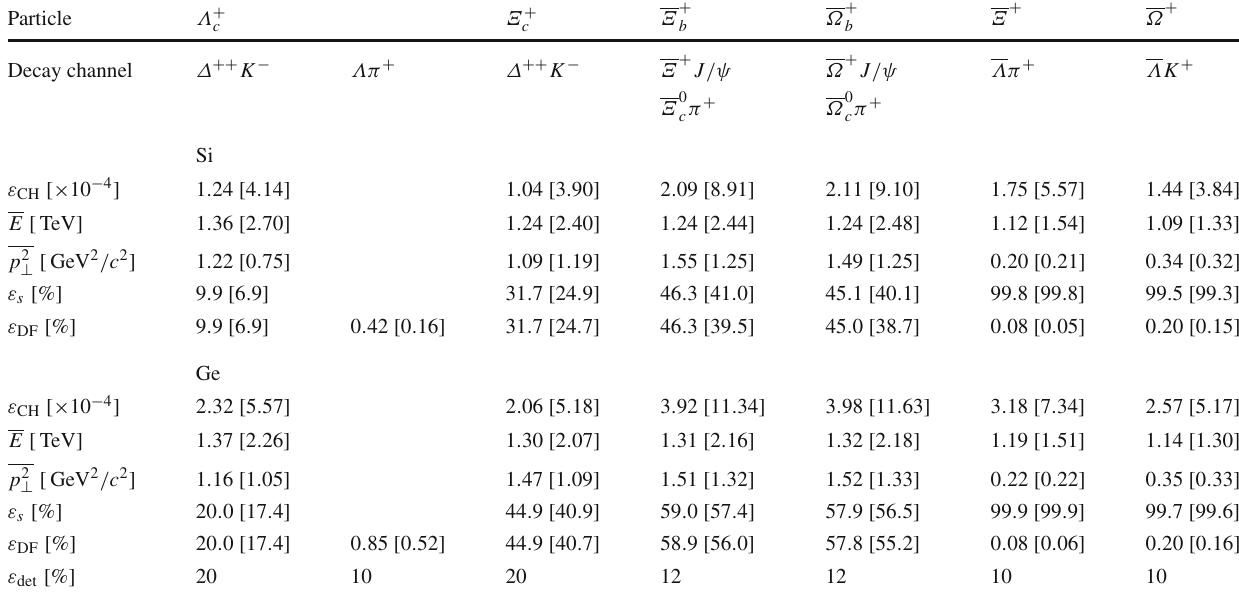
Table 4 Channeling, survival, decay flight and detector efficiencies, along with the average energy and squared transverse momentum of channeled baryons (before decay flight requirements), for a W target with a Si or Ge bent crystal in the S1 [ S2 ] scenario. Note that ε DF already includes ε s . The sensitivity study based on pseudo-experiments makes use of the complete energy spectrum after channeling, from which E and p 2 ⊥ reported here are obtained. All estimates, except ε